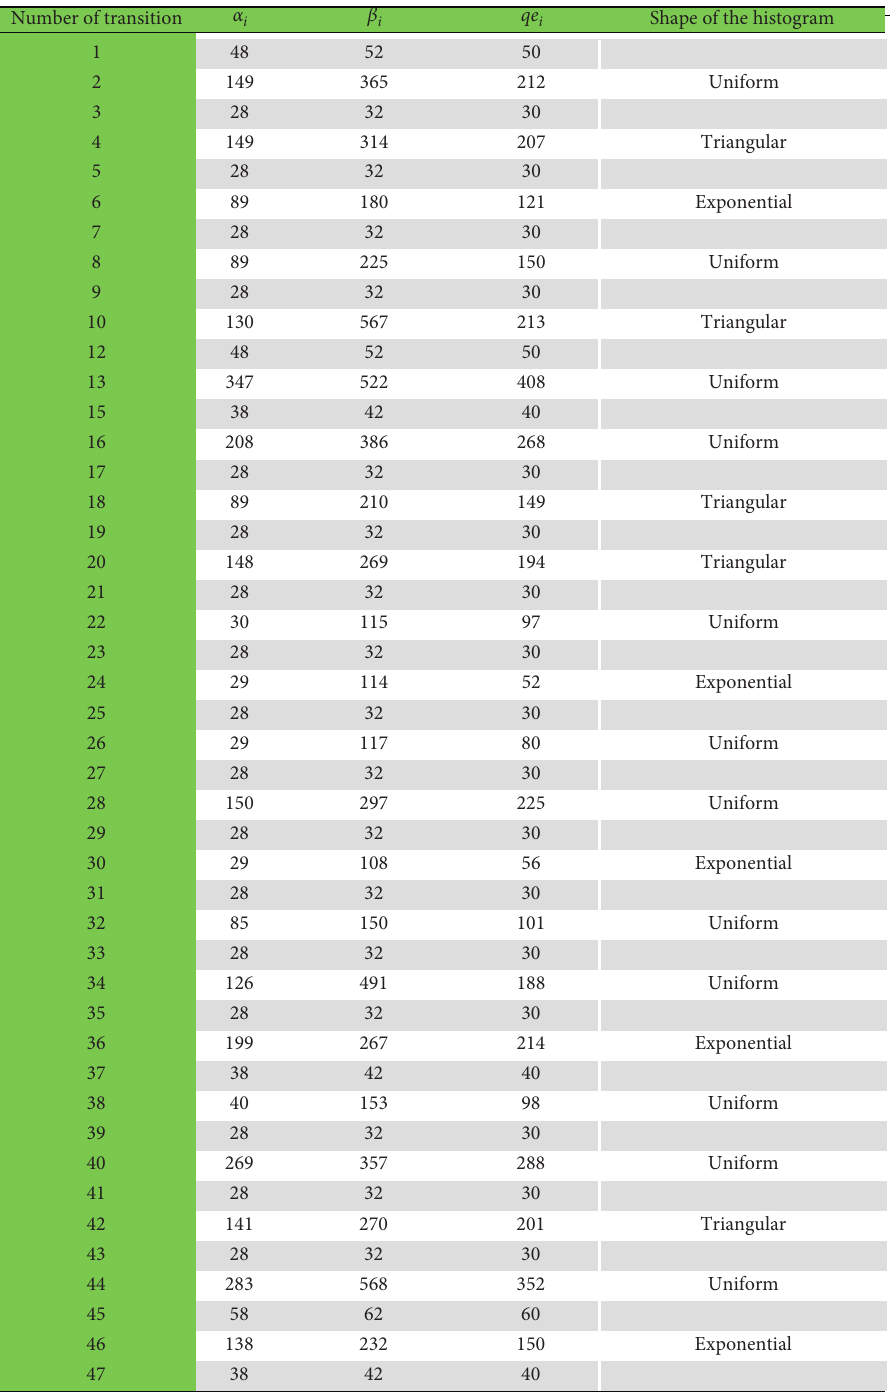
Table 2: Main characteristic of the